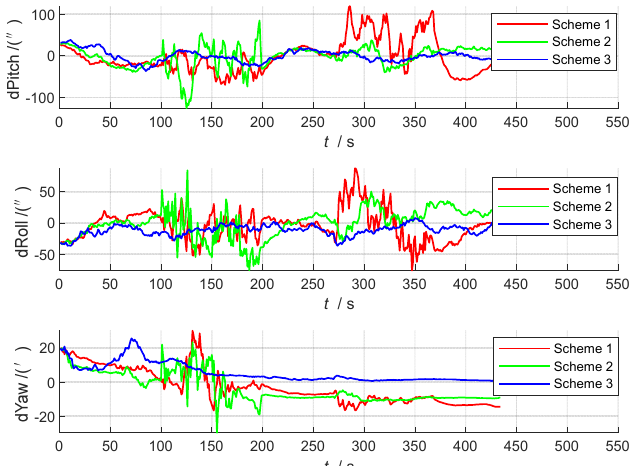
Figure 6. Comparison of attitude errors.